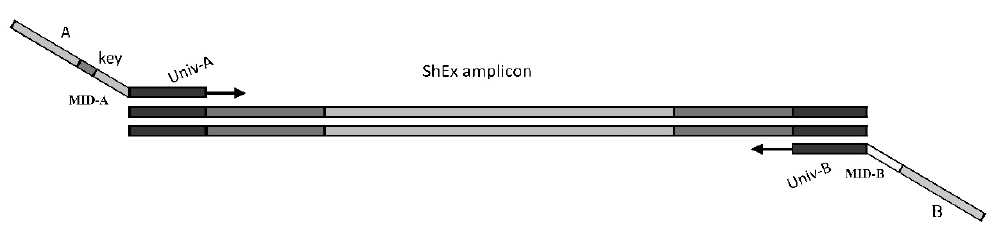
Figure 2. Scheme of the procedure for generating barcoded CG amplicons in oil palm hybrids. See text and Table S5 in Supplementary Materials for